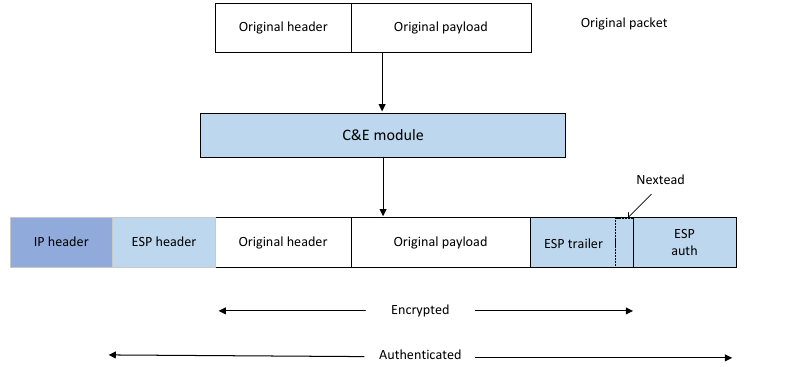
Figure 6. The packet encapsulation mode of C&E